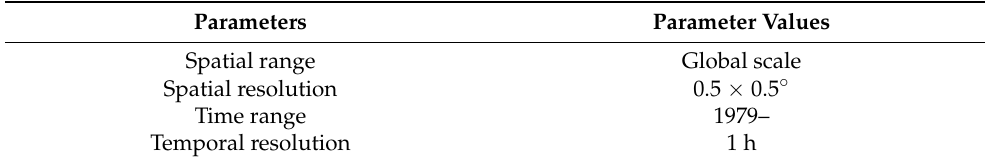
Figure 4. The reference data used in this paper: ( a ) A map of the SWH EC of the sea area around Britain at 06:41 on 19 March 2012. The purple dot in the figure indicates the location corresponding to the satellites SAR images. ( b ) The in situ sea surface elevation data measured by a GNSS buoy. ( c , d ) Ocean wave spectra measured by a GNSS buoy corresponding to M920 and M3120, respectively. ( e , f ) Orbital velocity spectra measured by a GNSS buoy corresponding to M920 and M3120, respectively. Table 2. The detailed parameters of the SWH EC provided by ECMWF.